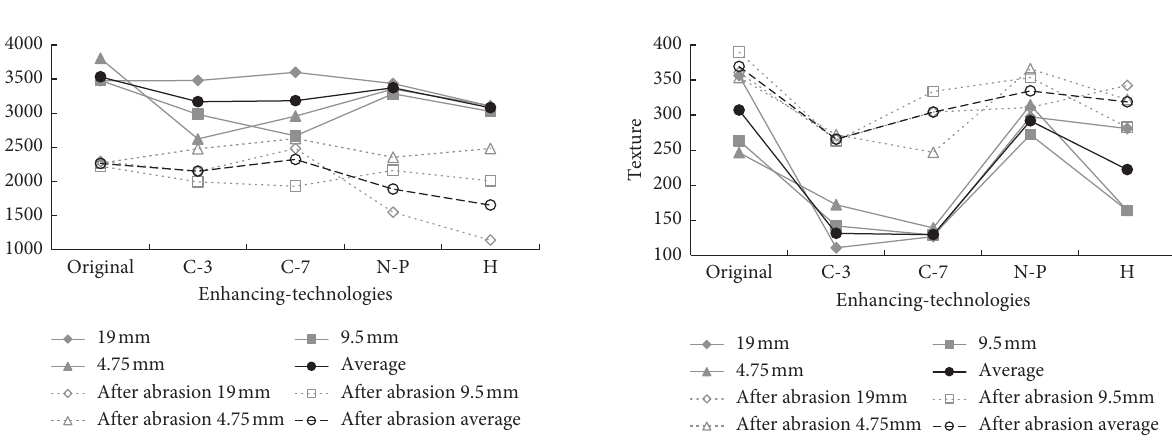
Figure 9: Texture of RA before and after chemical enhancing- technology.